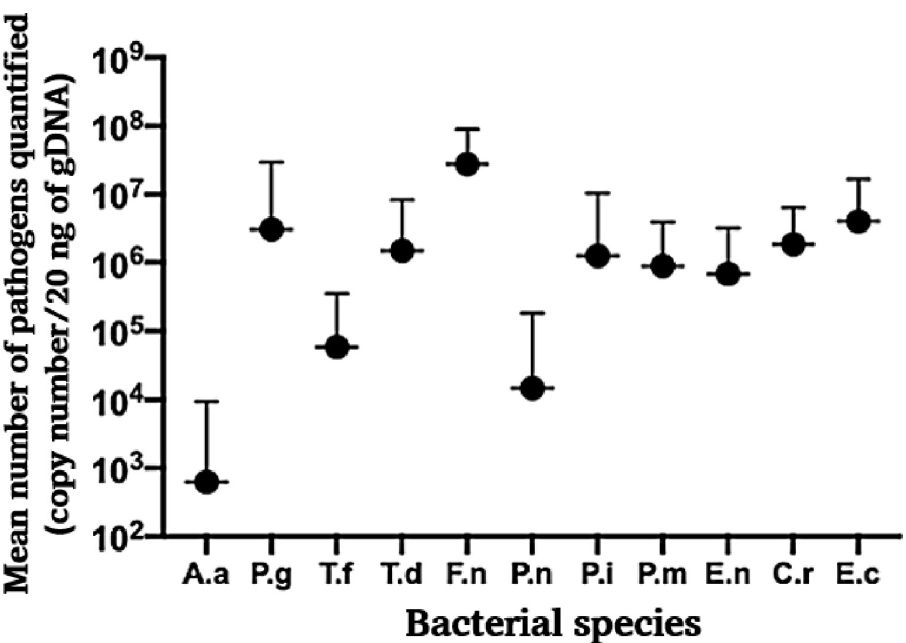
Fig 4. Overall mean numbers of bacteria in all groups. Bars show standard deviation. log = logarithm.